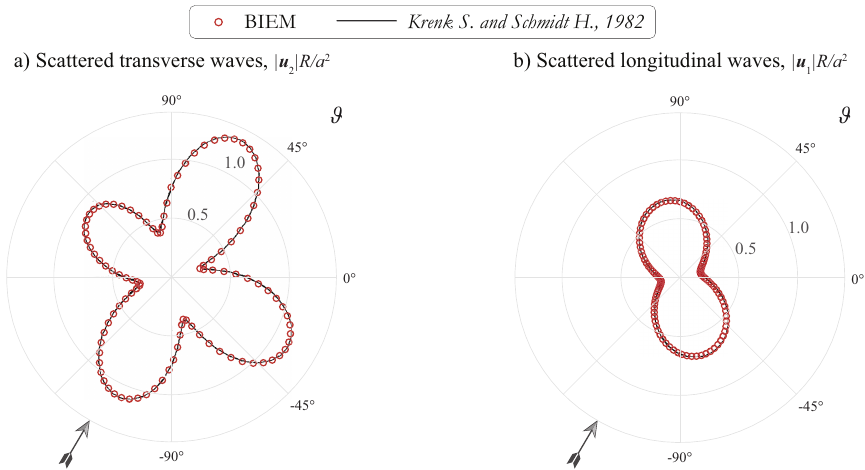
Figure 4. Amplitudes of transverse | u 2 ( 10 3 , θ = π /2 ± π /2, ϑ ) | ( a ) and longitudinal | u 1 ( 10 3 , θ = π /2 ± π /2, ϑ ) | ( b ) waves scattered by an open circular crack in the elastic space (glass) for the obliquely incident transverse SV-wave (incidence angle 30 ◦ to the plane x 3 = 0 and 90 ◦ angle to plane x 2 = 0 at k T 2 a = 2. Comparison with